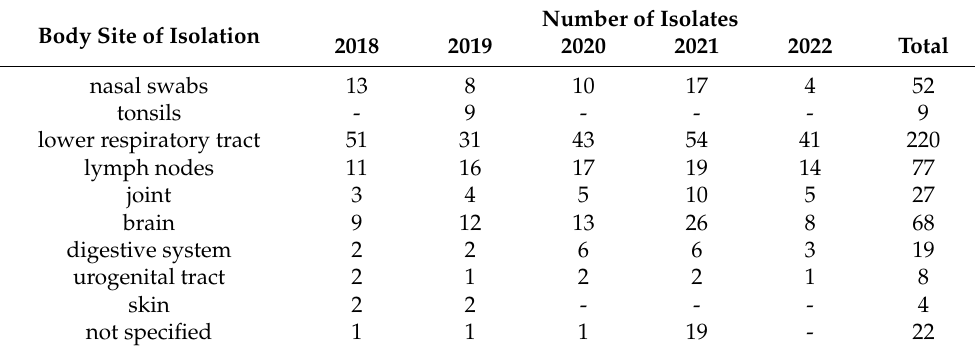
Table 2. The origin of S. suis isolates. Body Site of